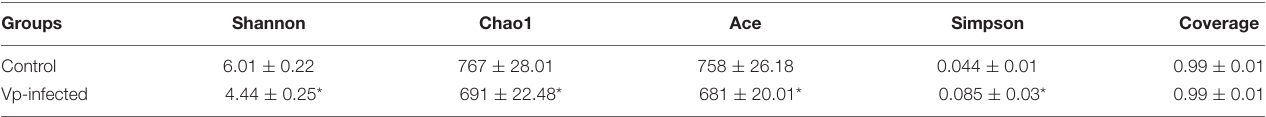
TABLE 3 | Evaluation of community richness and species composition (Chao1, Ace, Shannon and Simpson indices) of mouse gut microbiota after V. parahaemolyticus (Vp) infection + . Groups